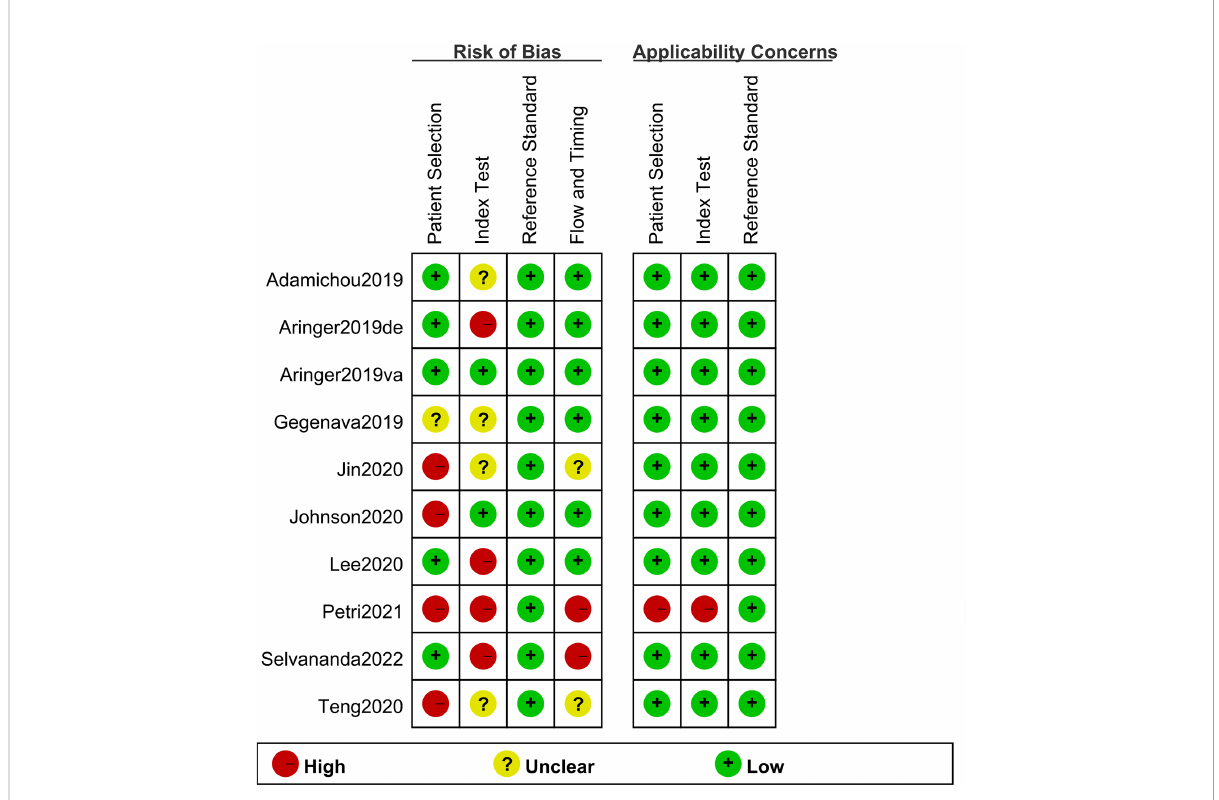
FIGURE 2 Methodological Quality. Risk of bias and applicability concerns in each study are